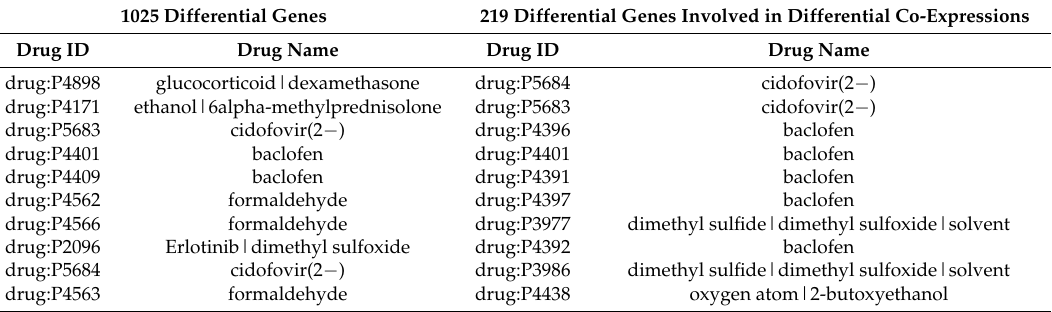
Table 3. Top 10 drugs predicted by using differential genes and differential co-expressions 1025 Differential